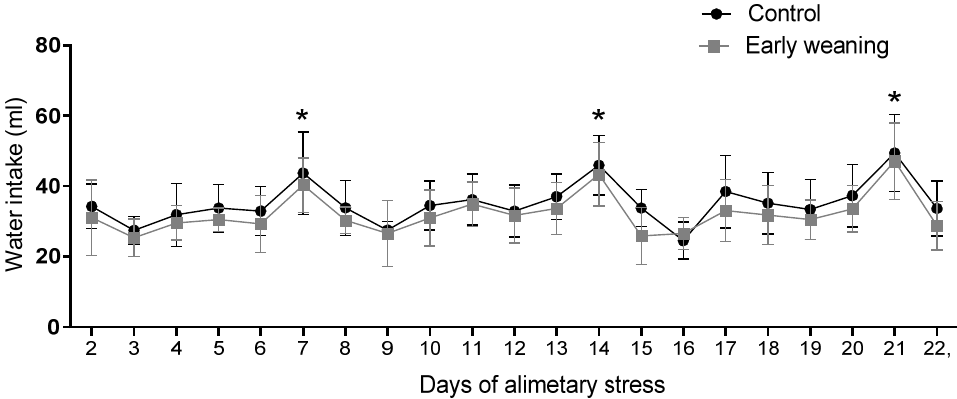
Figure 6. Effect of Early Weaning associated with chronic stress over water intake. Data were obtained every 24 hrs between days 2 and 7 of alimentary stress. Two-way ANOVA and Bonferroni’s post-hoc test n = 8. Data expressed as mean ± SD. * Shows the points at which both groups showed statistically higher values when compared to the lowest values, indicating peaks.